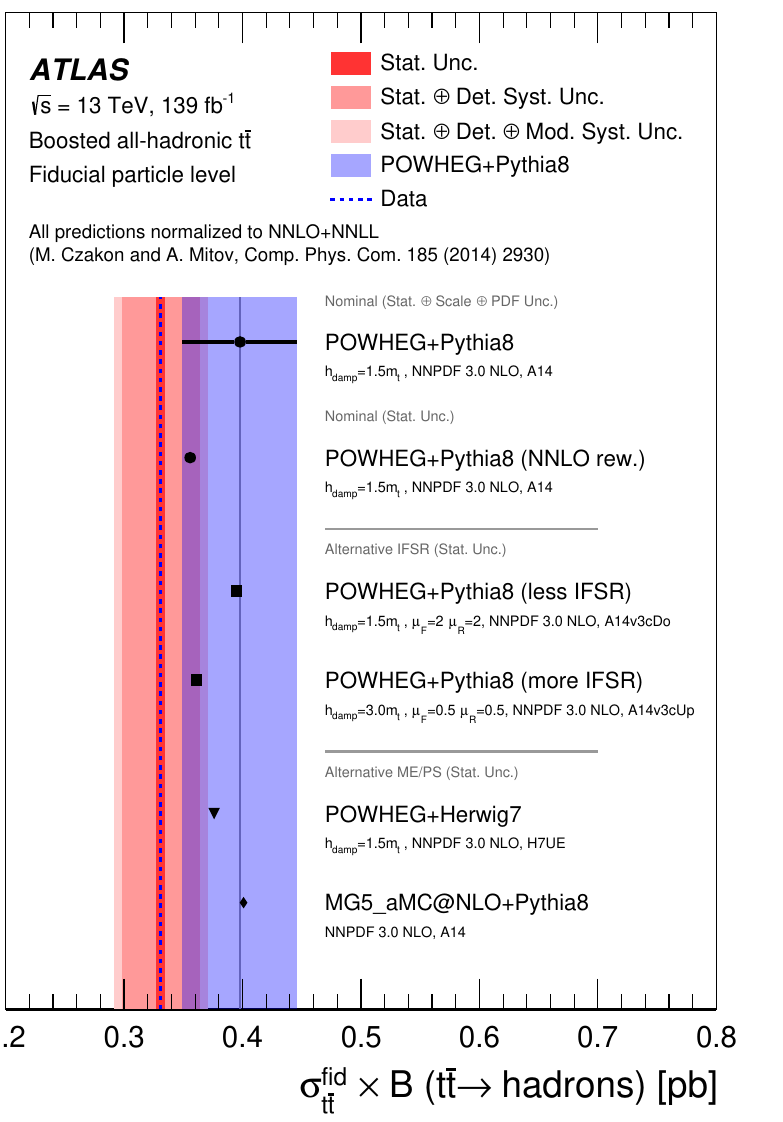
Figure 9 . The particle-level cross-section in the fiducial phase space σ fid multiplied by the t ¯ t t ¯ t all-hadronic decay branching fraction B ( t ¯ t → hadrons ) . The shaded (red) bands indicate the statistical, detector, and modelling uncertainties in the measurement. The Powheg+Pythia 8 event generator is used as the nominal prediction to correct for detector effects. The uncertainty associated with the nominal Powheg+Pythia 8 signal model (blue band) includes the statistical, scale, PDF, and NNLO+NNLL total inclusive calculation uncertainty. Other calculations show only the statistical uncertainty of the MC calculations, which is negligible and not visible in the figure. IFSR refers to both initial- and final-state